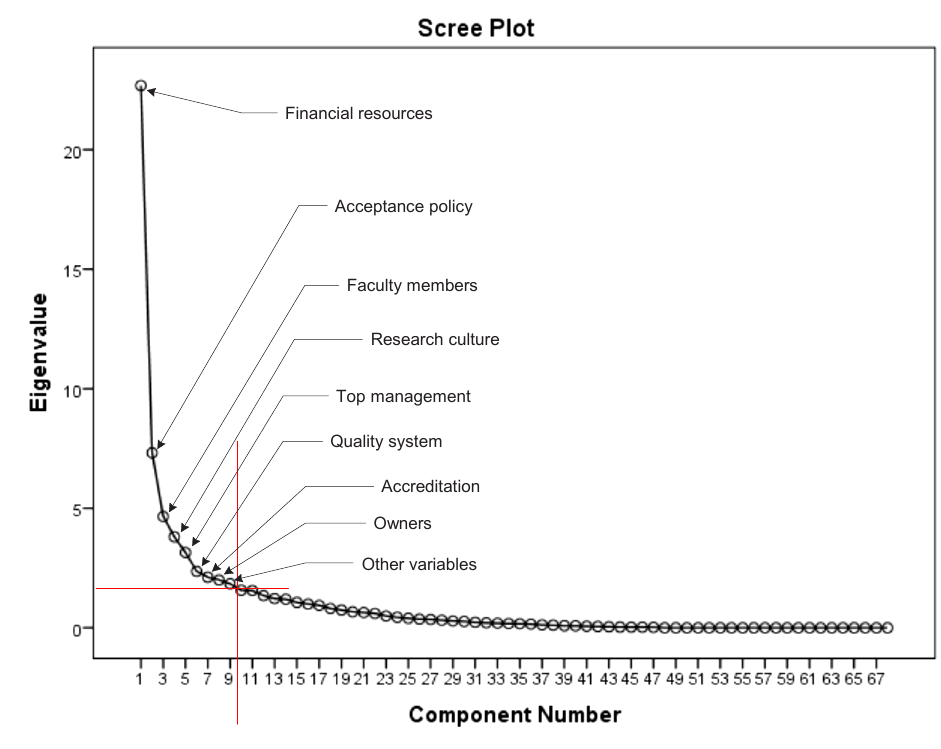
Figure 3. Eigenvalue of the nine factors